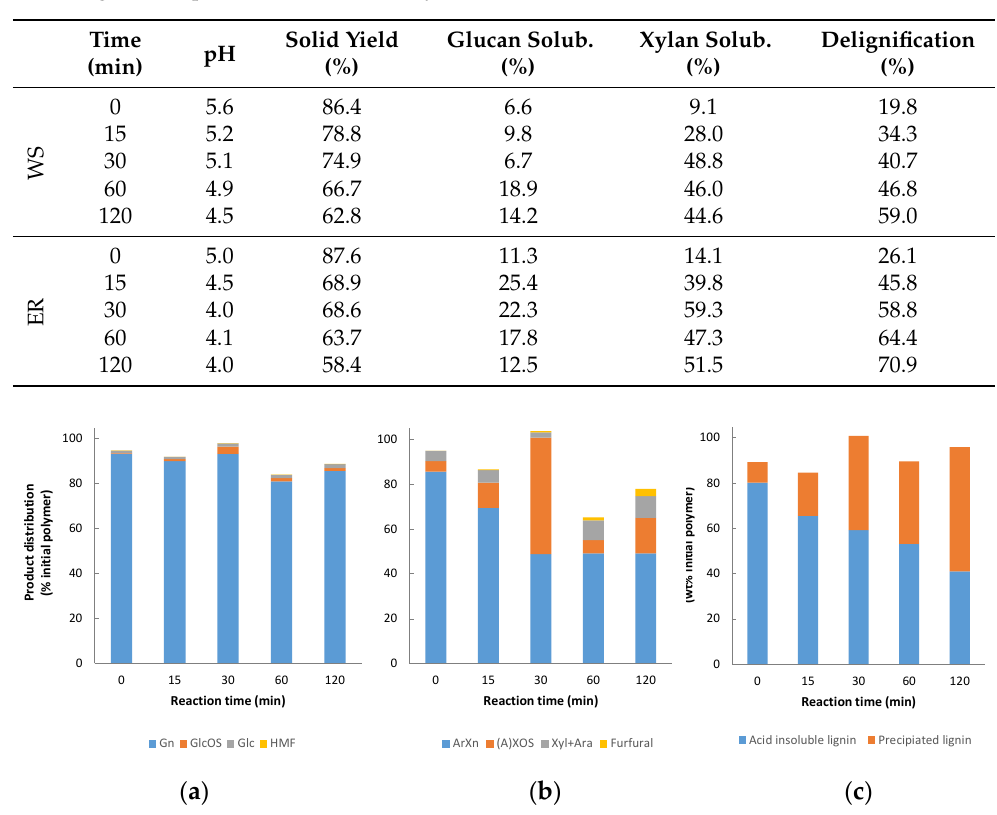
Table 2. Fractionation of wheat straw (WS) and eucalyptus residues (ERs) biomass using ethanol- based organosolv process (no added catalyst, 190 ◦ C).